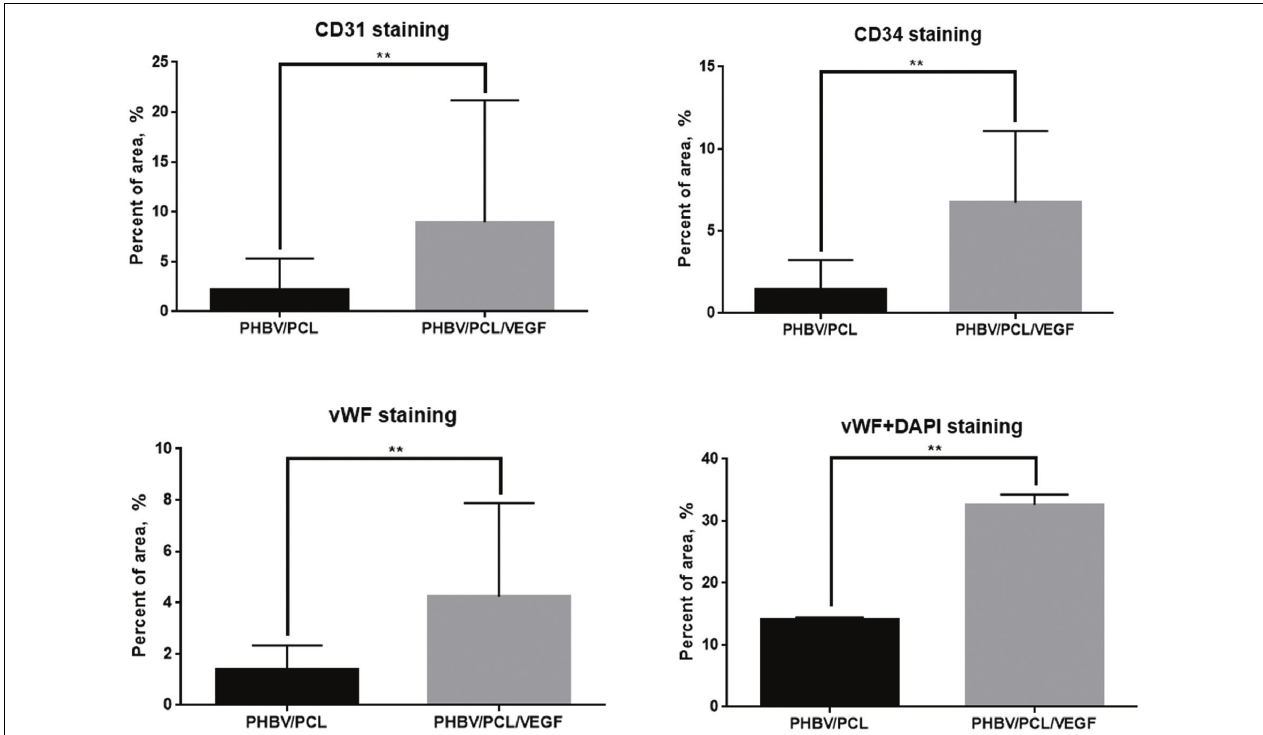
FIGURE 5 | In vivo performance of PHBV/PCL vascular grafts with and without VEGF: quantitative image analysis. Quantitative image analysis (three images per staining) confirmed an increase in number of CD31-, CD34, and vWF-positive cells in PHBV/PCL grafts with VEGF compared to those without after the implantation into rat abdominal aorta. In addition, this approach verified the increase in a total number of cells within the graft in PHBV/PCL/VEGF compared to PHBV/PCL grafts 6 months postimplantation. Data are represented as mean with standard deviation, ∗∗ P < 0.01, two-tailed Student’s t